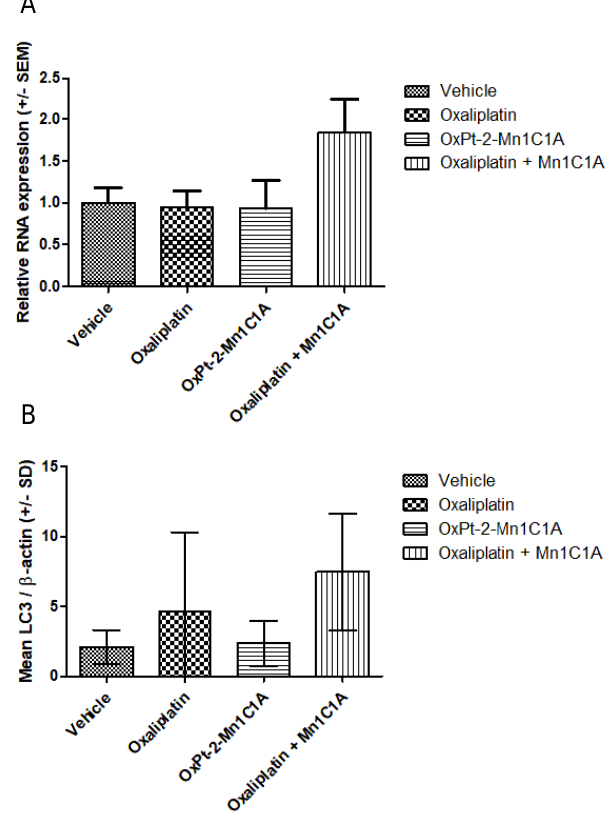
Figure 9. ( A ) VEGF expression (PCR) in tumoral tissue: relative RNA expression in fold change. Balb/c mice inoculated with CT26 cells treated by weekly intraperitoneal injection with the vehicle (8 mice), oxaliplatin (8 mice, 10 mg/kg/week), OxPt-2-Mn1C1A (9 mice, 10 mg/kg/week), and Mn1C1A + oxaliplatin (9 mice, 10 mg/kg/week). ( B ) Western blot for LC3 expression in tumoral tissue: mean LC3/β -actin ratio. Balb/c mice inoculated with CT26 cells treated by weekly intraperi- toneal injection with the vehicle (8 mice), oxaliplatin (8 mice, 10 mg/kg/week), OxPt-2-Mn1C1A (9 mice, 10 mg/kg/week), and Mn1C1A + oxaliplatin (9 mice, 10 mg/kg/week). 2.8. Autophagy Markers In Vivo Figure 9B represents the autophagy marker LC3 measured in Western blot, showing a significantly higher production of the LC3 protein in the Mn1C1A + oxaliplatin group. There was no difference in SQSTM1 production among the groups. 2.9. Histological Analysis No significant difference in histological tumoral analysis was found between the groups. Caspase 3 expression in immunohistochemistry was dependent on tumoral re- sponse. Luxol fast blue coloration in paw skin showed no significant difference between the groups. 3. Discussion We designed and synthesized the first Pt(IV) complexes as covalent conjugates be- tween oxaliplatin and MnSOD mimics derived from complex Mn1 (MAG) [13,31,43] to evaluate them for their antitumoral activity and effect on oxaliplatin-induced peripheral neuropathy. Three Mn-uncoordinated Pt(IV) conjugate OxPt-x-1C1A (x = 1OH,1,2) were prepared and characterized. In situ, with half-lives t 1/2 between 30 min and 2 h, Mn coor- dination induces hydrolysis and cleavage of the Pt-O linkage bond with the folding of the